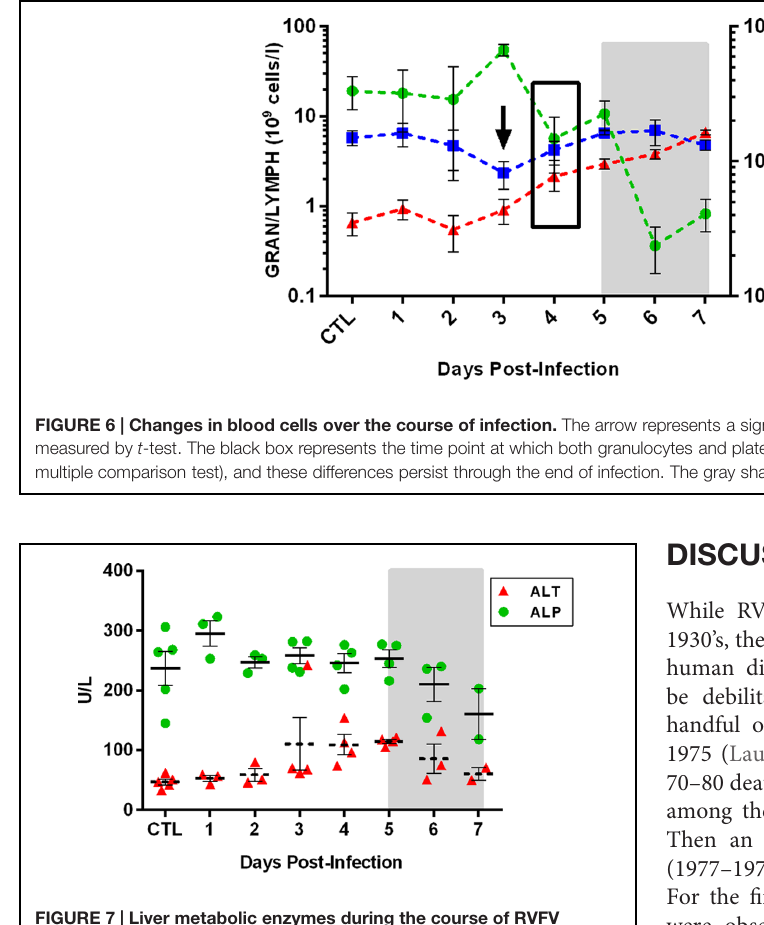
FIGURE 7 | Liver metabolic enzymes during the course of RVFV infection of Lewis rats. 14-parameter blood chemistry analysis was performed on each rat at the time of sacrifice. Alanine transaminase (ALT; a marker of liver cell damage) and alkaline phosphatase (ALP; produced by liver cells) are shown. Significance was evaluated using one-way ANOVA and no significant differences over time were found ( p = 0.1 and p = 0.08 for ALT and ALP,